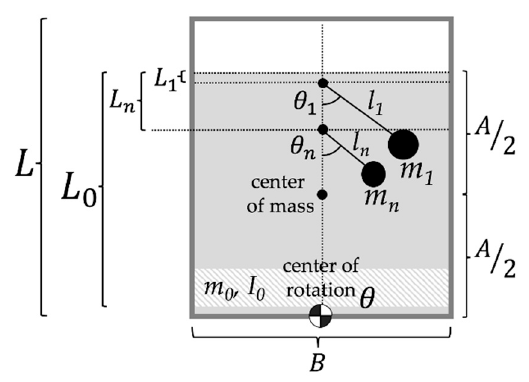
Figure 5. Pendulum model of the slosh, including n th oscillations of the free surface.